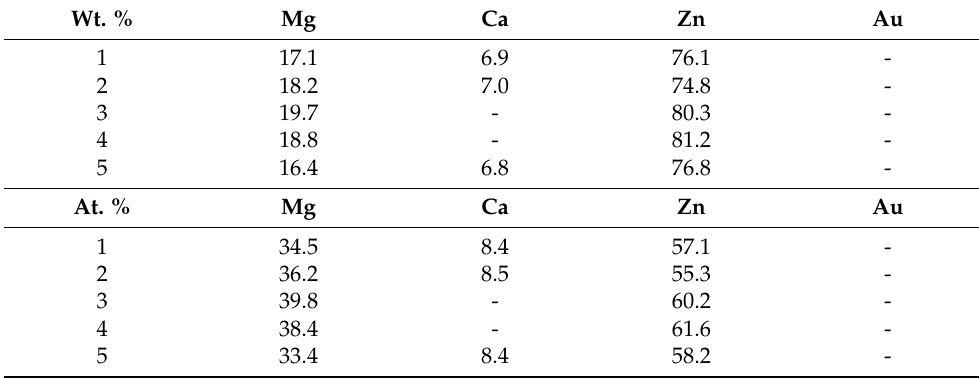
Table 5. EDS results from the areas marked in Figure